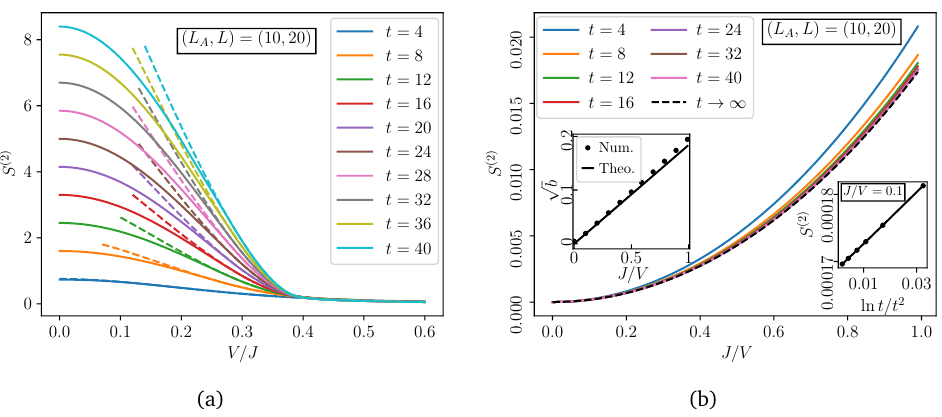
Figure 5: (a) The S ( 2 ) obtained from Type 2(D / QA / QB) saddles as a function of V / J for V < 0.6 J at various times. For a given value of V and t , the solid and dashed lines, if both exist, correspond to the Type 2(D) (i.e. replica diagonal) and Type 2(QA / QB) (i.e. replica quasi-diagonal) saddle, respectively; otherwise only Type 2(D) saddle solution exists for this value of V . Note the Type 1 saddle solutions are not shown in (a). (b) The Type 2(D) saddle S ( 2 ) as a function of J / V for J ≤ V . Long time behavior converges to a J 2 / V 2 scaling form. The left inset shows that the coefficient b in front of a log t / t 2 correction term fits well with the theoretically proposed value (see Eq. (31) and below); the right inset shows the linear S ( 2 ) – log t / t 2 scaling behavior at small J / V